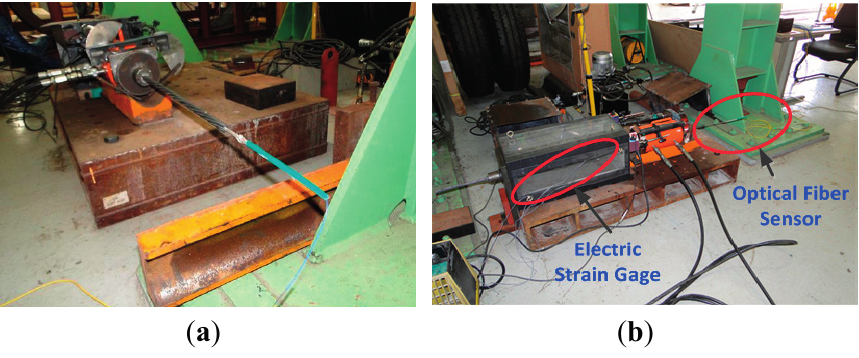
Figure 5. ( a ) Sensing strand specimen and ( b ) setting of strand performance test.